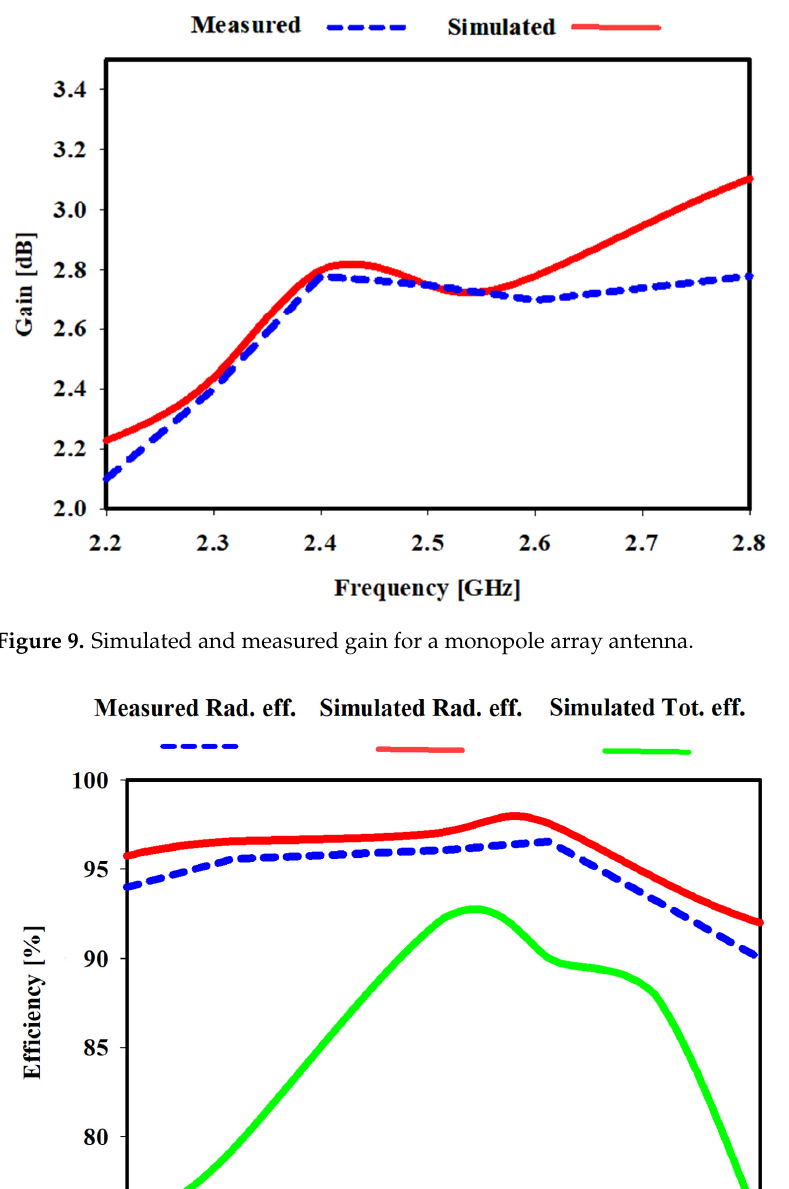
Figure 8. ( a ) The simulated and measured reflection coefficient of the suggested printed ML mono ‐ pole antenna and ( b ) the reflection coefficient measurement setup.